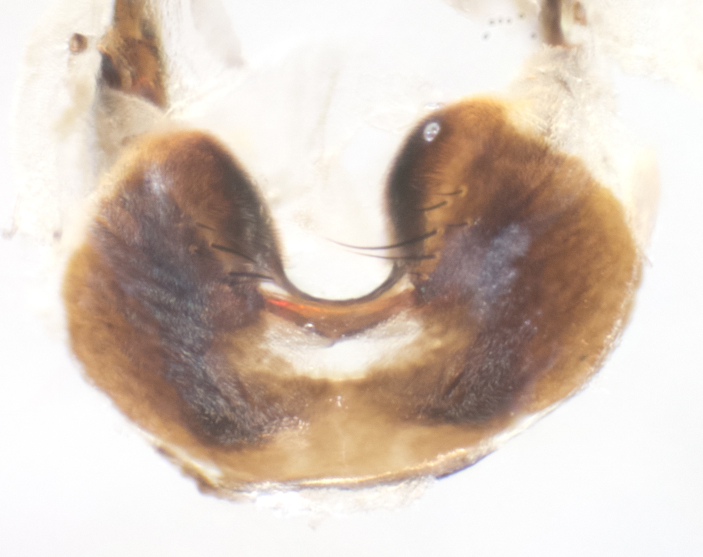
sternite 5, ventral view